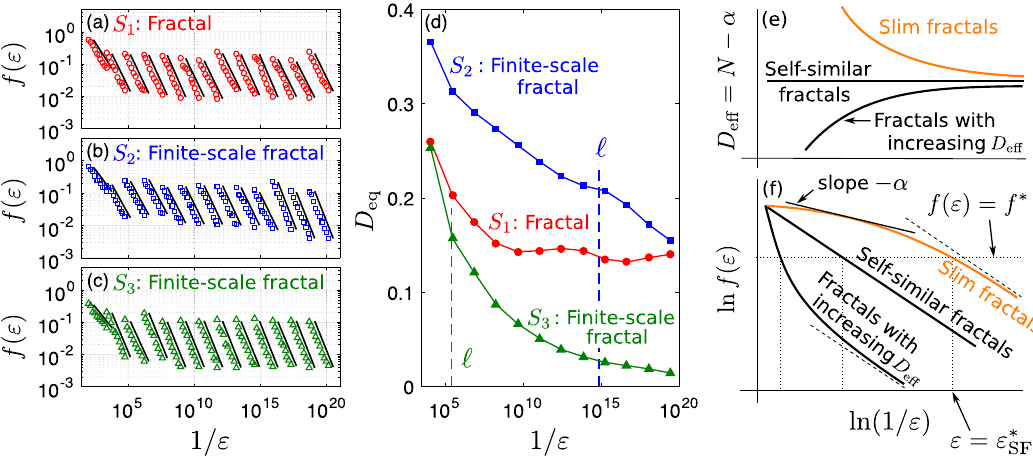
FIG. 6. Dimension of slim fractals. (a) – (c) Uncertainty function f ð ε Þ estimated by sampling pairs of points ε apart on a vertical line segment centered at P 1 , P 2 , and P 3 in Fig. 4 for the roulette system with surface shapes S 1 , S 2 , and S 3 , respectively, for successively , computed using Eq. (12) with L ¼ 2 × 10 − 3 and D estimated as the smaller segments (left to right). (d) Equivalent dimension D eq eff slope for each segment in (a) – (c) from the linear least-squares fit [lines in (a) – (c) are offset for clarity]. The vertical dashed lines indicate the fractality length scale l for S 2 and S 3 . (e,f) Illustration of the effective dimension (e) and the final-state uncertainty (f) as a function of ln ð 1 = ε Þ for three types of